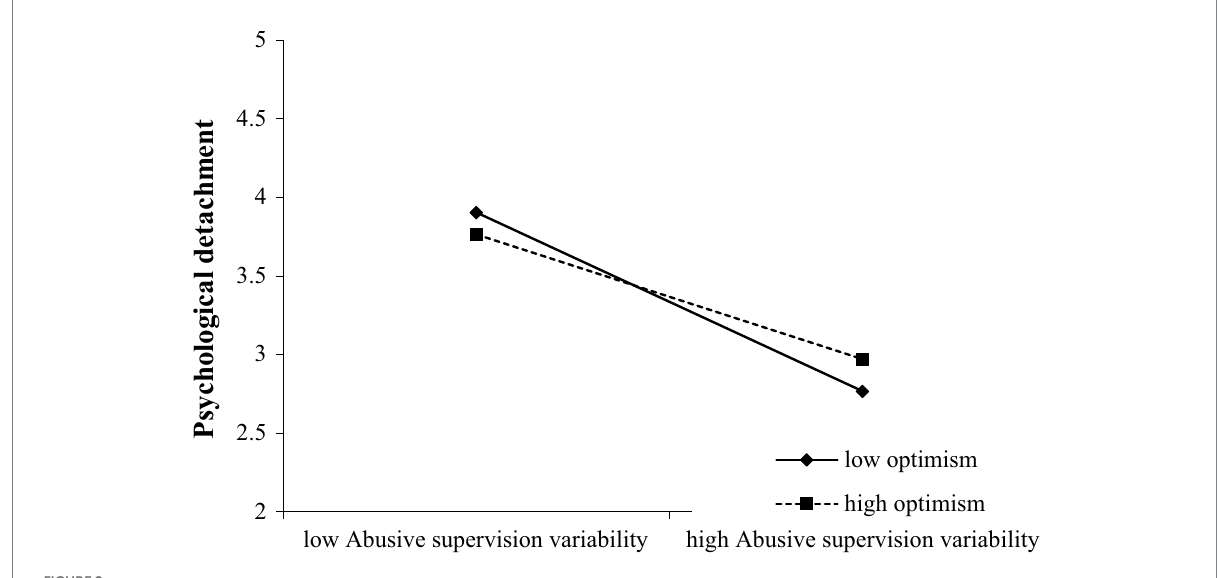
FIGURE 2 Interaction of abusive supervision variability and optimism in predicting psychological